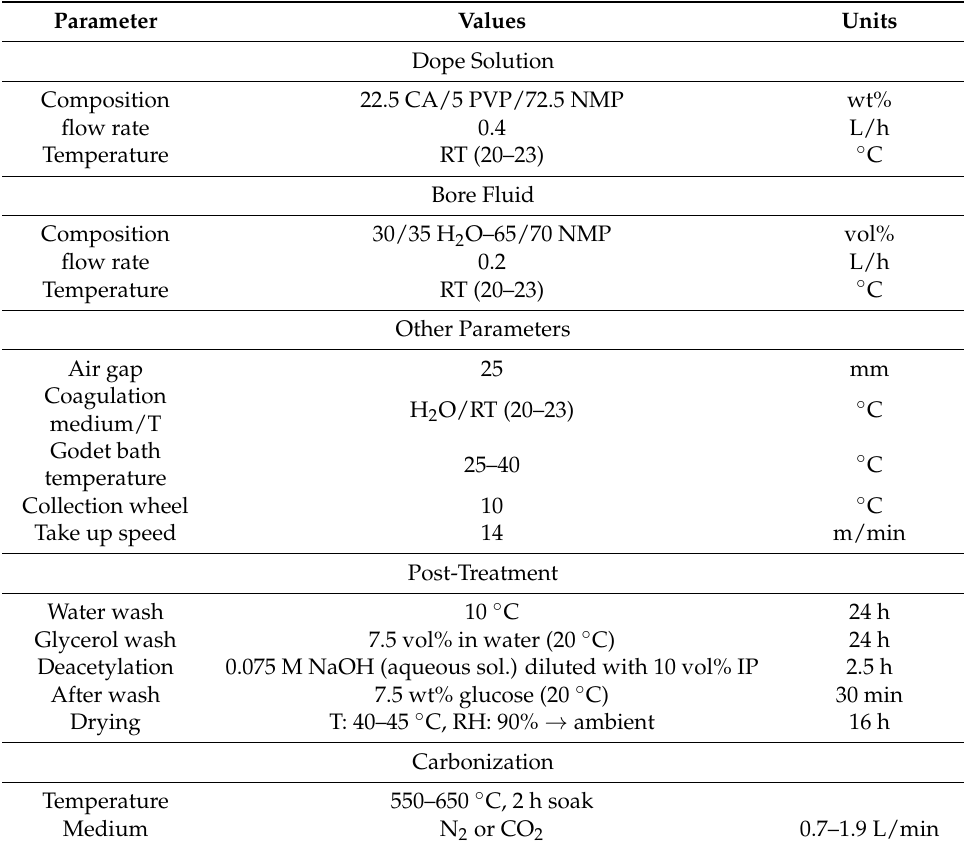
Table 1. Optimized parameters for spinning, pre-treatment and carbonization processes. Parameter Values